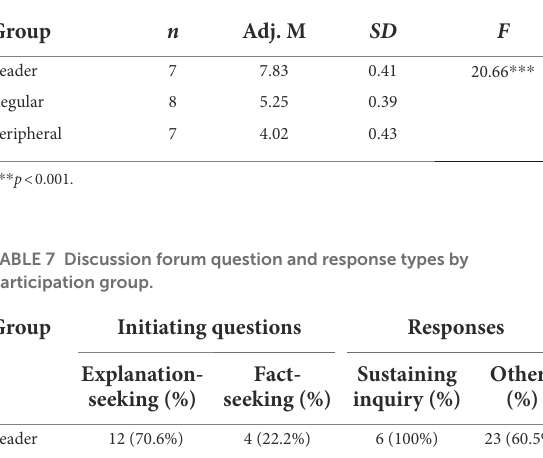
TABLE 6 Means and standard deviations for unit 2 systems thinking scores by participation group.